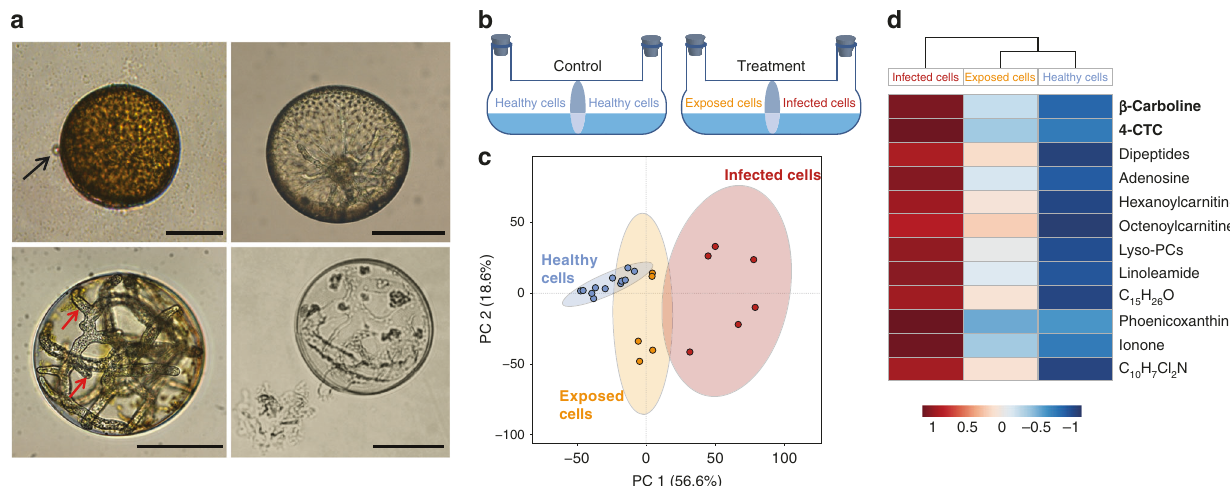
Fig. 1 Metabolomics investigation of the oomycete infection in the marine diatom Coscinodiscus granii . a Life stages of the parasitoid oomycete Lagenisma coscinodisci infecting the diatom host Coscinodiscus granii . A single zoospore (highlighted by black arrow) attached to the algal surface (upper left). L. coscinodisci hyphae developing within the algal cytoplasm (upper right). The thallus converts into a sporangium from which mature infectious zoospores are produced (lower left). After zoospore release the empty parasitoid thallus remains in the shell of the dead diatom (lower right). Scale bars equal 50 µ m. b Co-cultures of healthy or infected diatoms in chambers separated by a membrane that allows the passage of exudates between the physically separated cells. The controls consist of healthy cells in both compartments. In the treatment, healthy cell populations were exposed to the chemical cues released by infected algal cells. c The three treatments (healthy, exposed, or infected) can be discriminated after 5 days of co-culturing by their cellular metabolome in the PCA score plot. The ellipses represented the 95% con fi dence region predicted by the statistical calculation. d Cellular metabolites up-regulated during infection and exposure are represented in a heatmap based on their relative MS intensities (red color for high intensity, blue for low intensity)